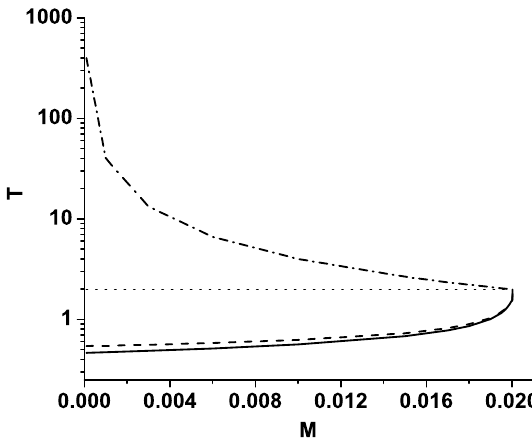
Figure 6 . The temperatures of the bubble and the black hole as functions of the black hole rest mass. The solid, dashed, doted and dot-dashed lines are the temperatures at the outer side of the bubble wall, inner side of the wall, initial black hole surface and final black hole surface respectively. We set M + = 0 . 02 , Λ + = 3 , Λ − = 0 . 03 and G = 1 , and change the black hole rest mass M − .